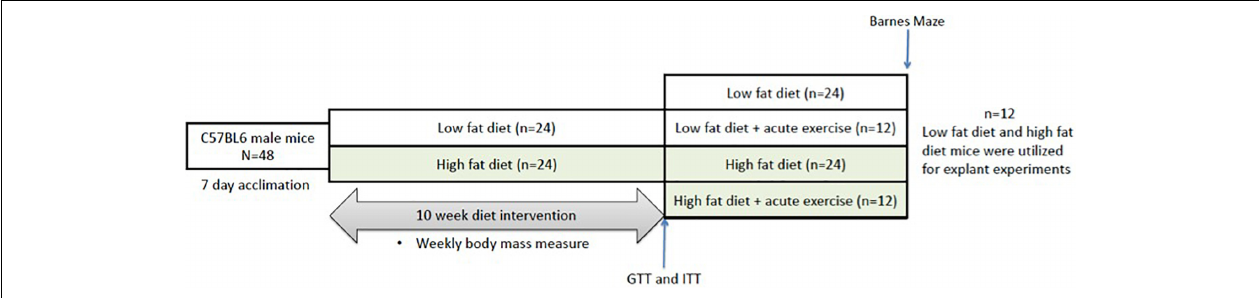
FIGURE 1 | Representative image of the experimental timeline. Mice underwent 10 weeks of either low or high fat feeding followed by Barnes maze testing and GTT and ITT. GTT, glucose tolerance test; ITT, insulin tolerance